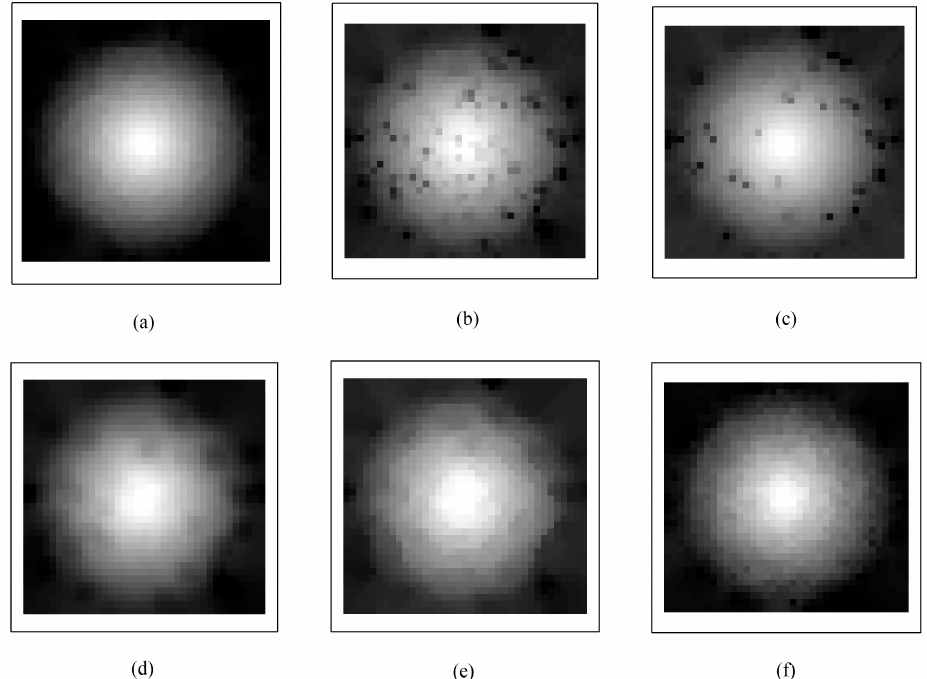
Figure 2. CHMs produced by ( a ) natural neighbor (NN) interpolation of original sample points; ( b ) NN interpolation of the contaminated data set with the contaminating proportion of 10%; ( c ) highest point method (HPM); ( d ) mean filter; ( e ) median filter; and ( f ) our method.